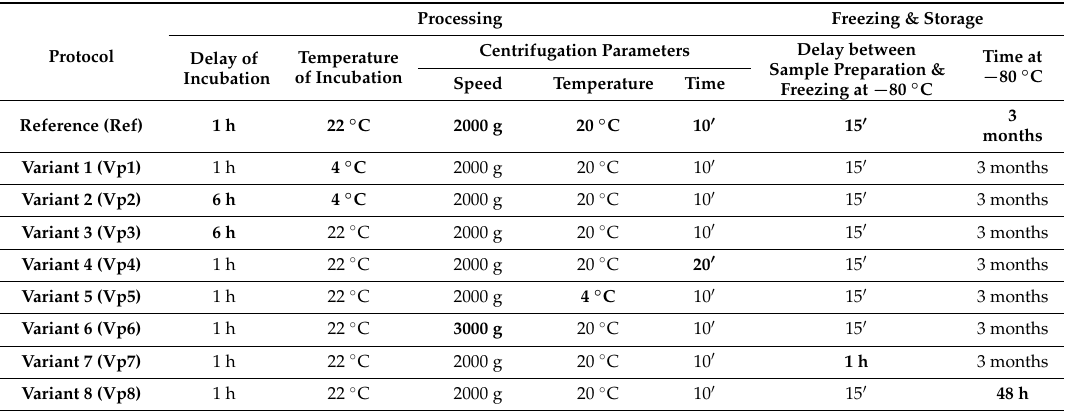
Table 1. Overview of the study protocol. Fasting blood samples are obtained and handled according to the reference protocol or one of eight variant